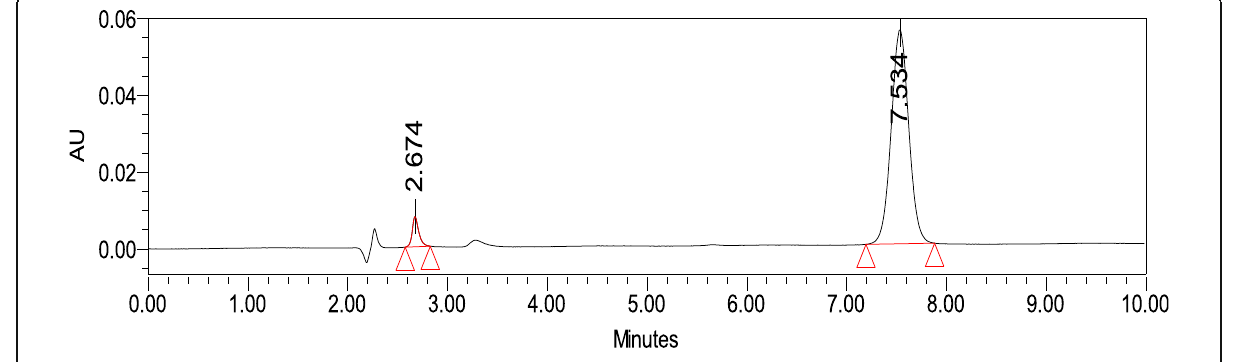
Fig. 2 HPLC chromatogram of BQF demonstrating system